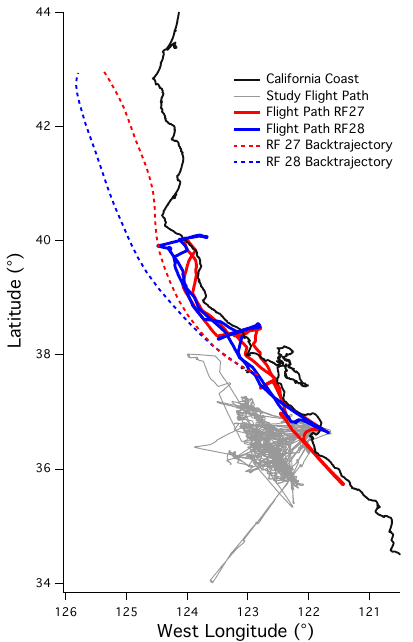
Fig. 12. Path of additional flights RF 27 (red) and RF 28 (blue) com- pared to the path of all other flights in the present study (grey). Dot- ted lines are back-trajectories (24h) for air masses measured during the middle of each flight. RF 27 and RF 28 were coastal gradient flights conducted on clear (RF 27) and cloudy (RF 28)